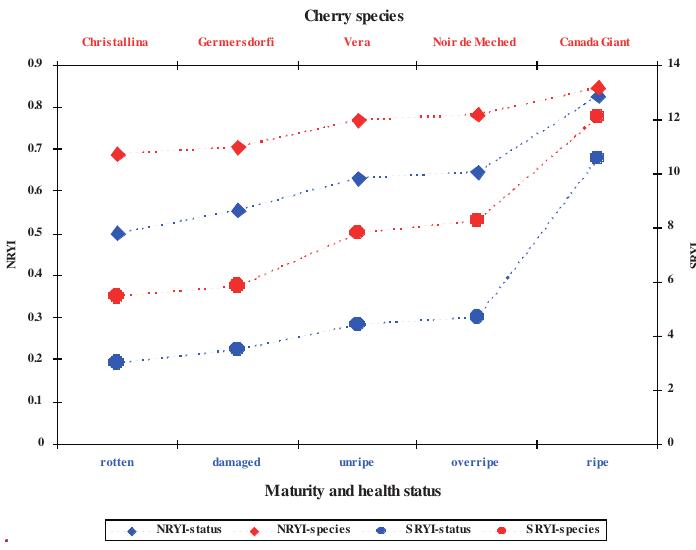
Figure 4. SRYI and NRYI values of cherry fruits